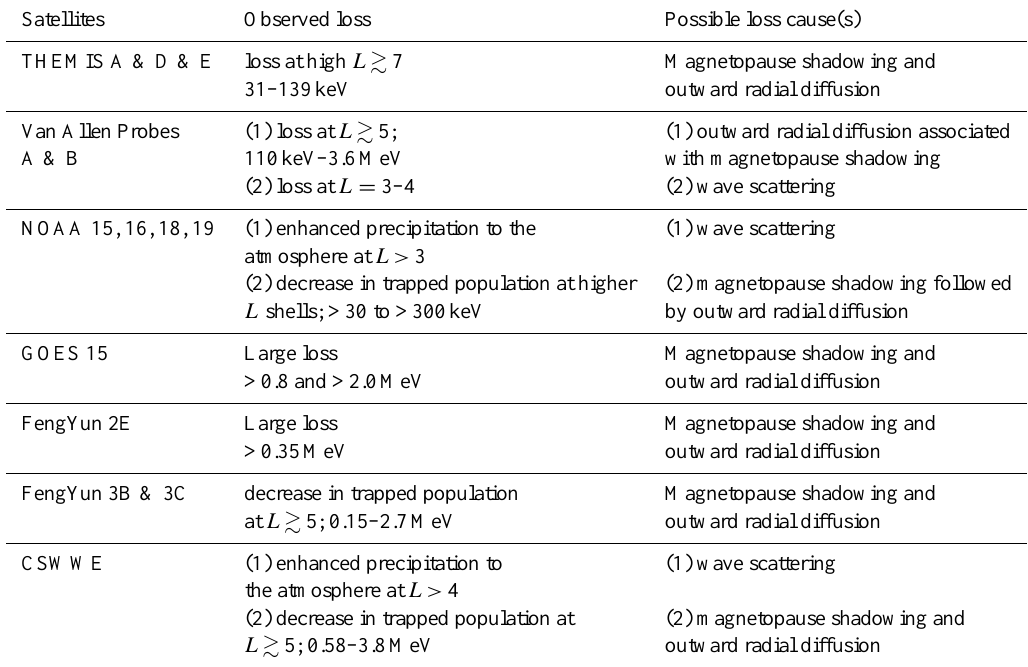
Table 1. A list showing the electron loss feature observed by each satellite and the corresponding possible cause(s). Satellites Observed